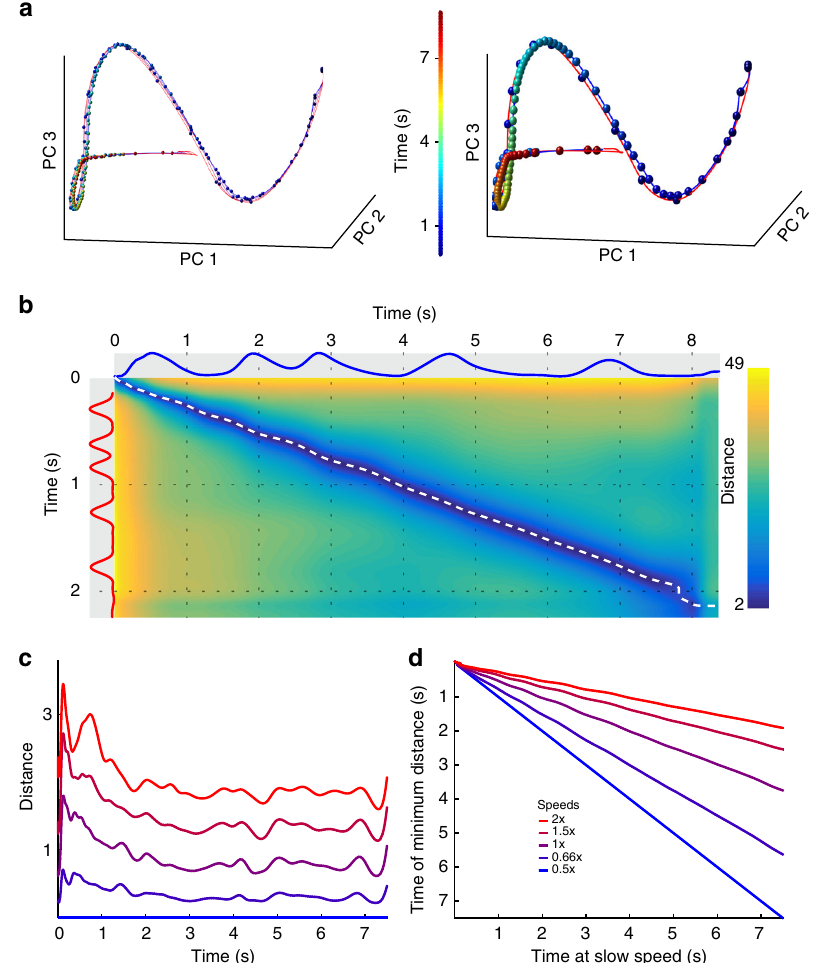
Fig. 7 Temporal scaling relies on parallel neural trajectories at different speeds. a Trajectory of RNN activity at fi ve speeds projected onto the fi rst three principal components. Right: same data, but only the slowest (blue line) and fastest (red) speeds are plotted to highlight the difference in speed of the two trajectories. Colored spheres indicate absolute time in each trajectory (100 ms between spheres), and reveal the differences in the speeds of the trajectories in neural phase space. b Euclidean distance matrix between the fast and slow trajectories in neural space at each point in time along each trajectory (network size: N = 1800). Blue and red traces along the axes show the output. White dotted line traces the minimum distance between the two trajectories, which never reaches zero. c The minimum distance along the slowest trajectory from each other speed. d The relative timing at which the minimum occurs in each trajectory. For example, at 4 s in the slowest speed ( x -axis) the trajectory is closest to the 2× speed at 1